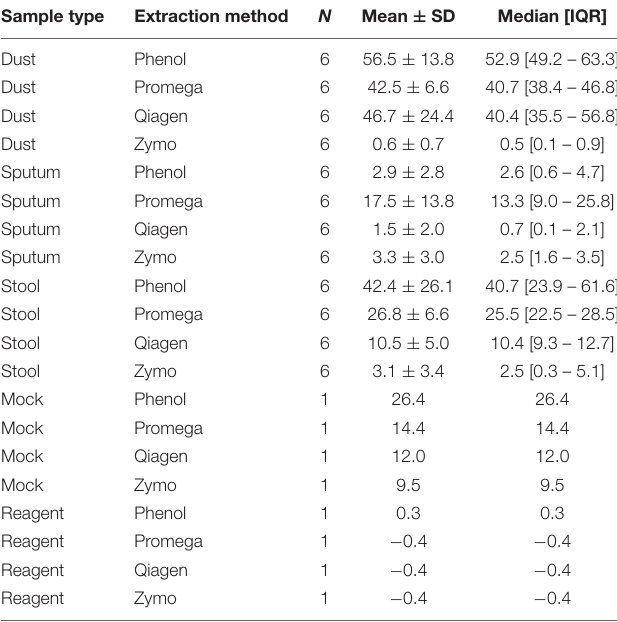
TABLE 1 | DNA yields stratified by sample type and extraction